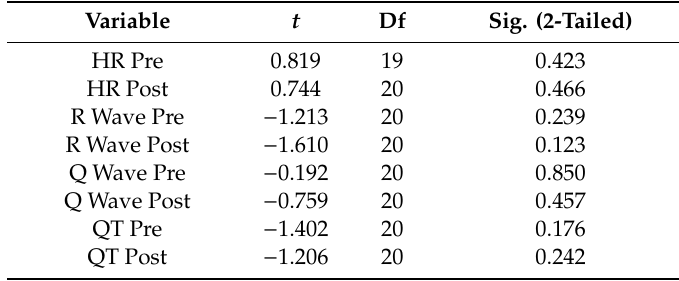
Table 4. Independent t -test for sex di ff erences in the electrocardiographic variables.